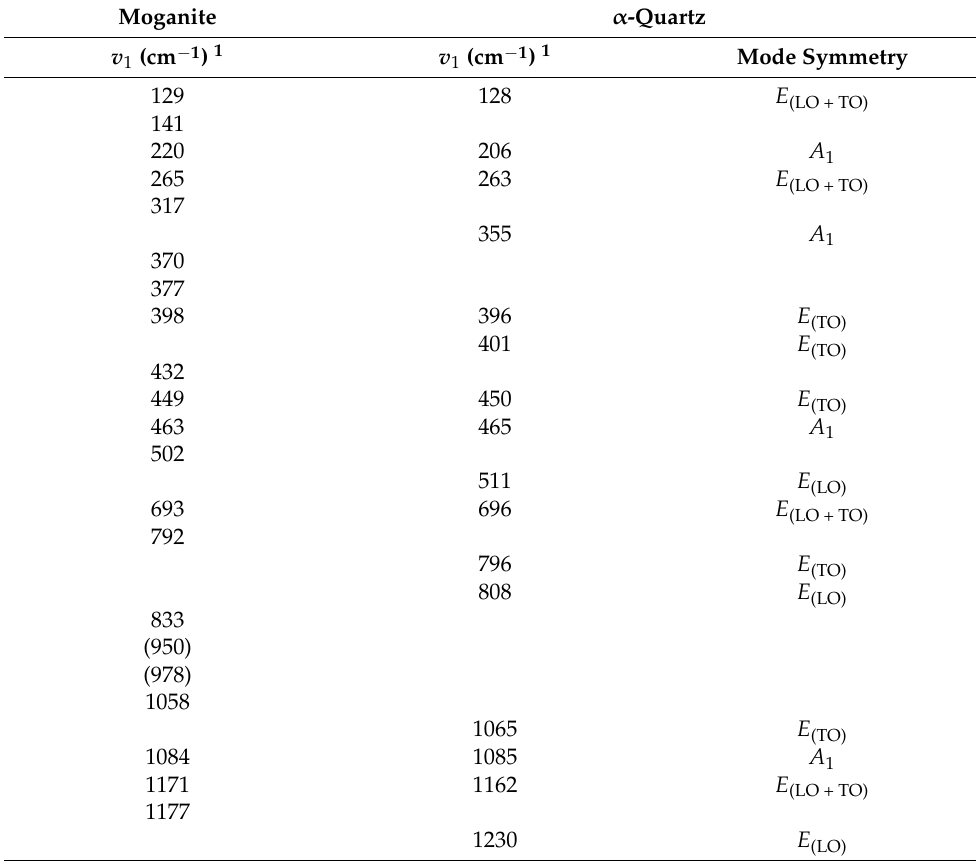
Table 1. Raman frequencies of moganite, and α